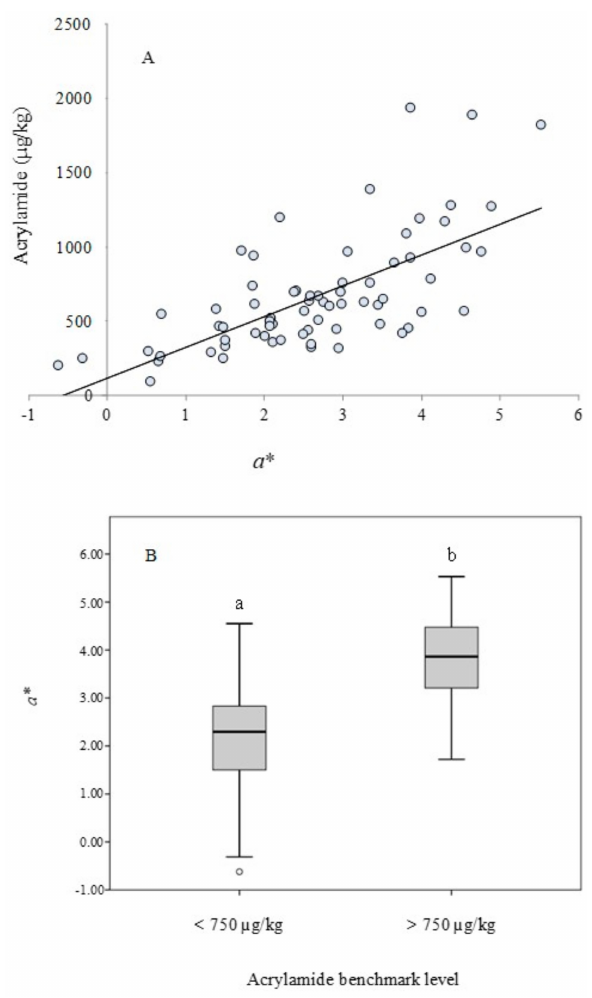
Figure 3. Relationship between color and acrylamide content ( µ g / kg) in potato crisps marketed in Spain. Linear regression between acrylamide content and the color parameter a * (r 2 = 0.6736, p < 0.0001) ( A ) and box-and-whisker plot of color parameter a * according to the acrylamide levels using the benchmark level as the threshold (750 µ g / kg) ( B